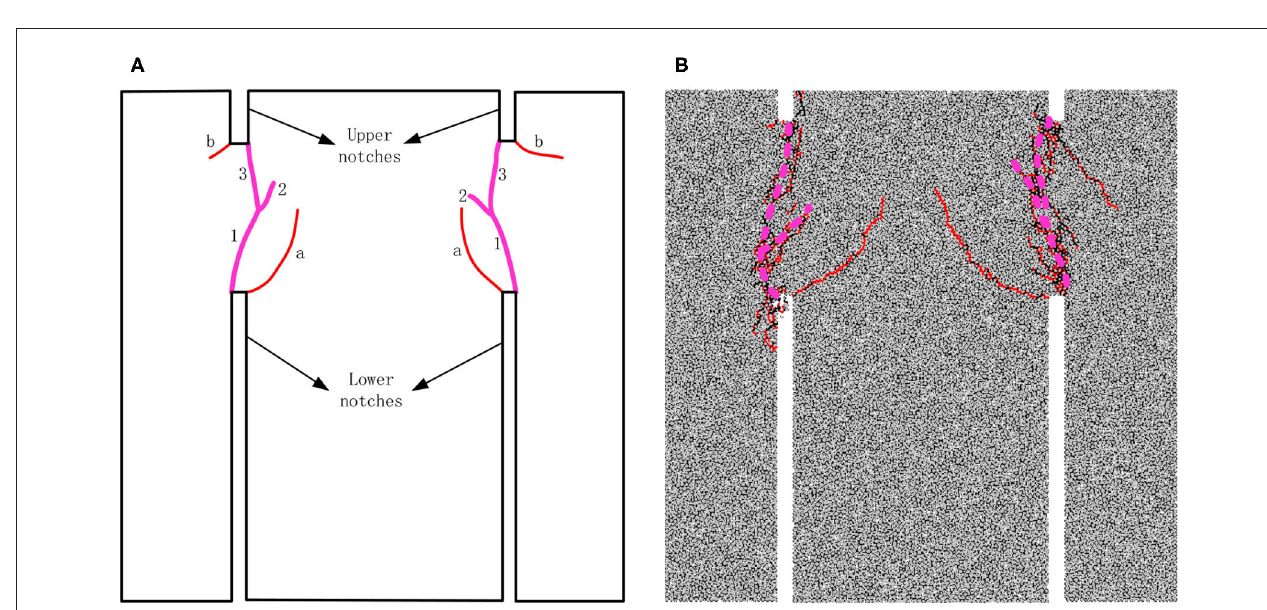
FIGURE 5 | Fractures in punch-through tests: (A) and (B) are the laboratory [29] and numerical fractures,